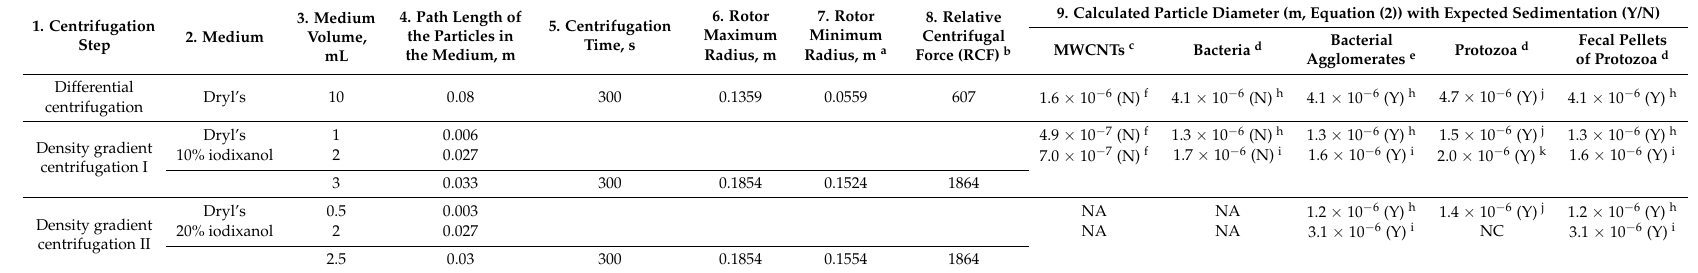
Table 3. Parameters employed in separating protozoa from bacteria, fecal pellets and MWCNTs, and estimated minimum diameters of the system components that would pellet (Column 9) at the relative centrifugal forces and centrifugation time used in the